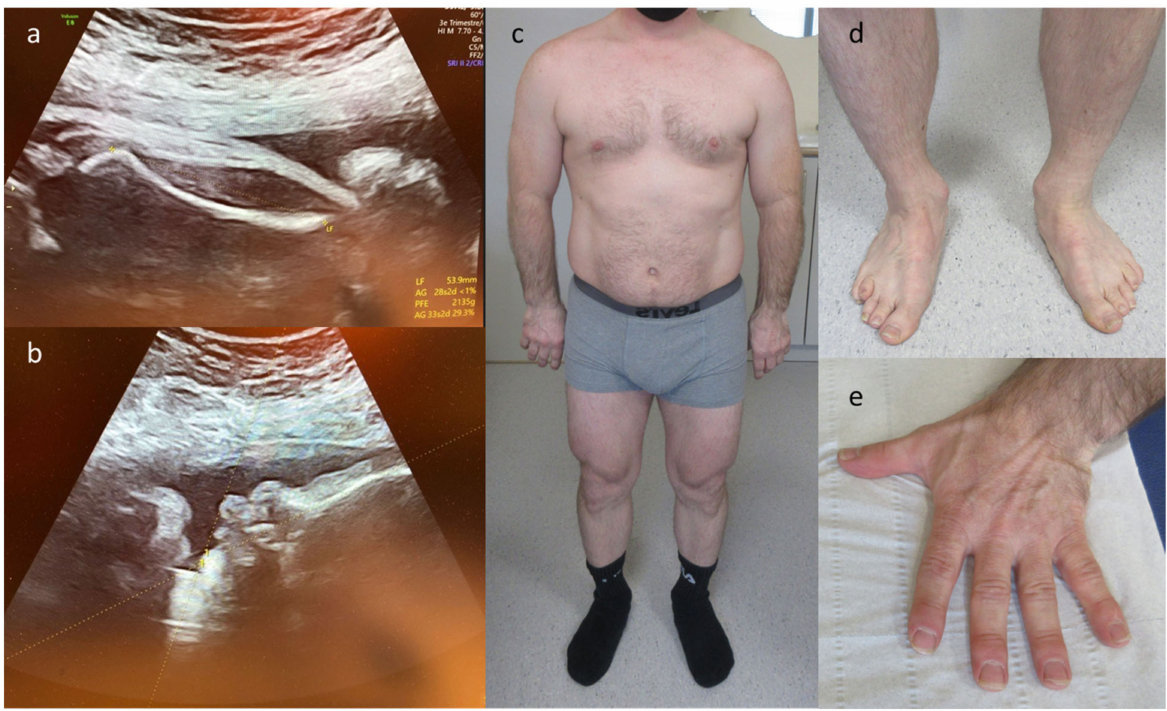
Figure 3. Phenotype of fetus and father with Stickler syndrome due to a COL2A1 variant. ( a ) 3rd trimester ultrasound showing femoral shortening and bowing; ( b ) 3rd trimester ultrasound showing pathological lower facial angle at 44 ◦ corresponding to microretrognathia; ( c ) Affected father: short and stocky appearance; ( d ) Feet of affected father; ( d ) Feet of affected father: right 4th toe and left 4th and 5th toes are proximally implanted and the lower limbs show bowing at the ankles; ( e ) Left hand of affected father: short hand and